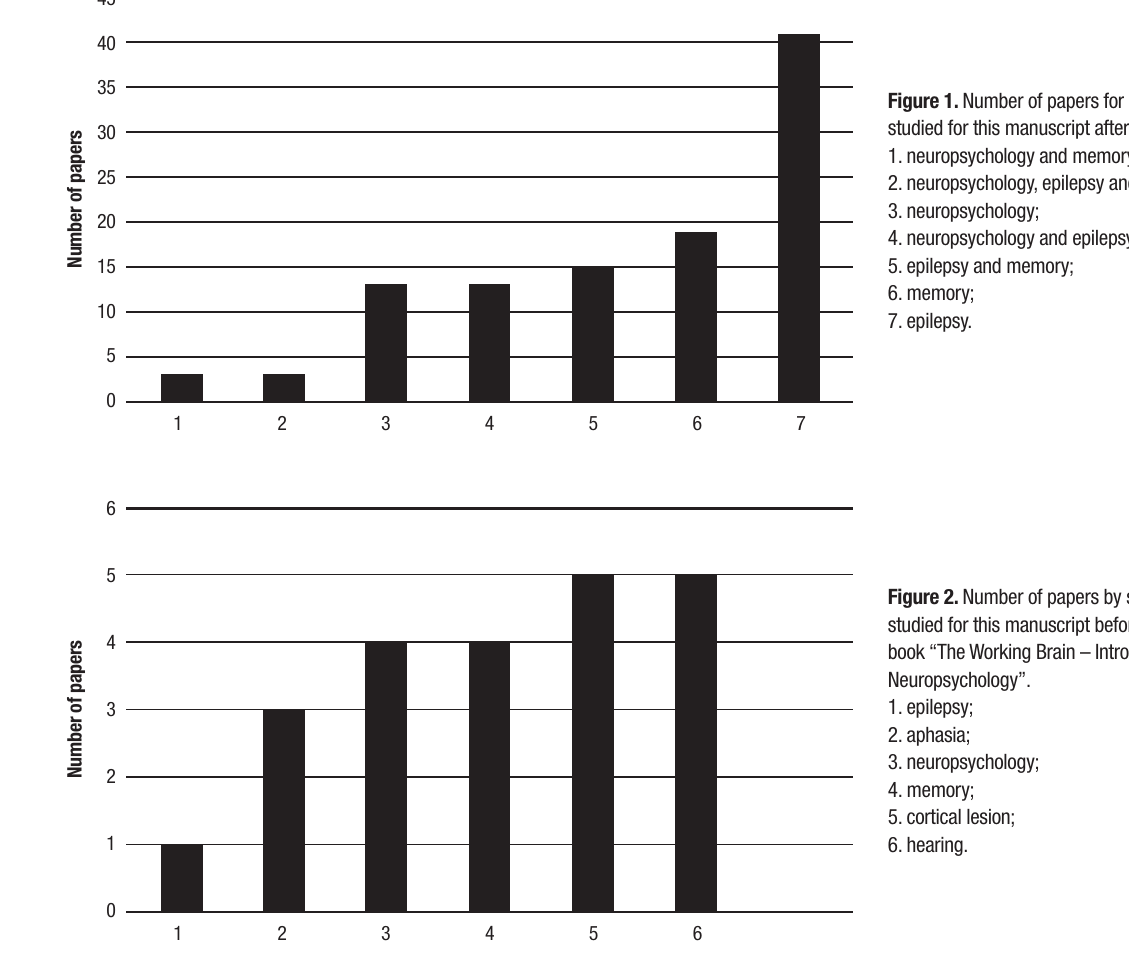
Figure 1. Number of papers for each subject studied for this manuscript after 1992.